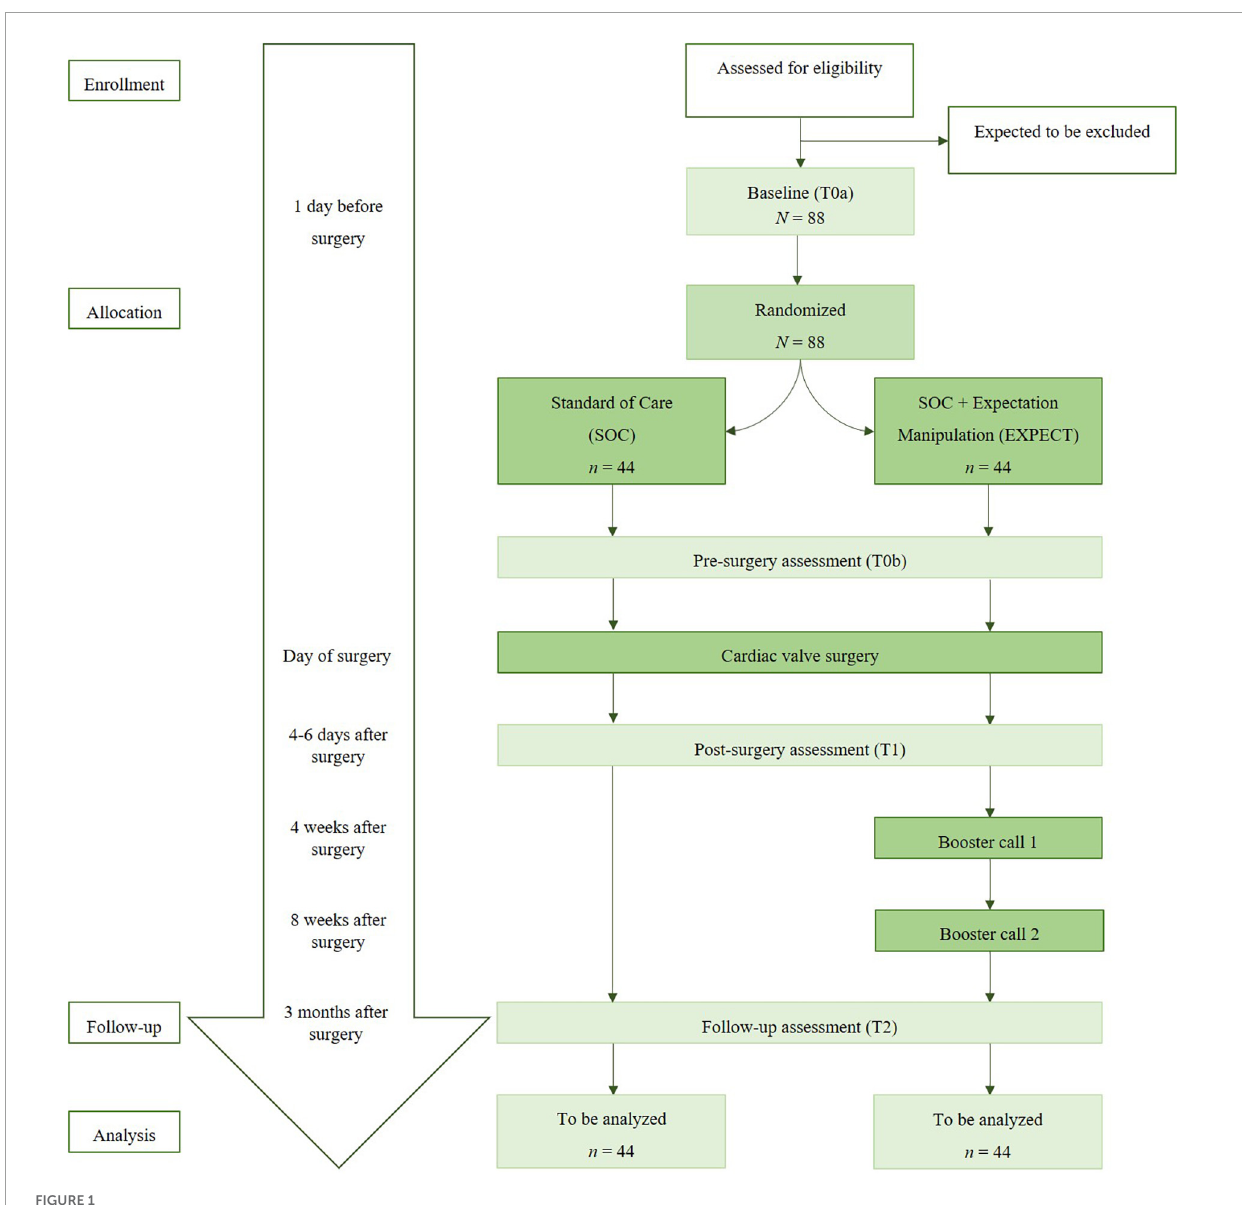
FIGURE1 Study flow